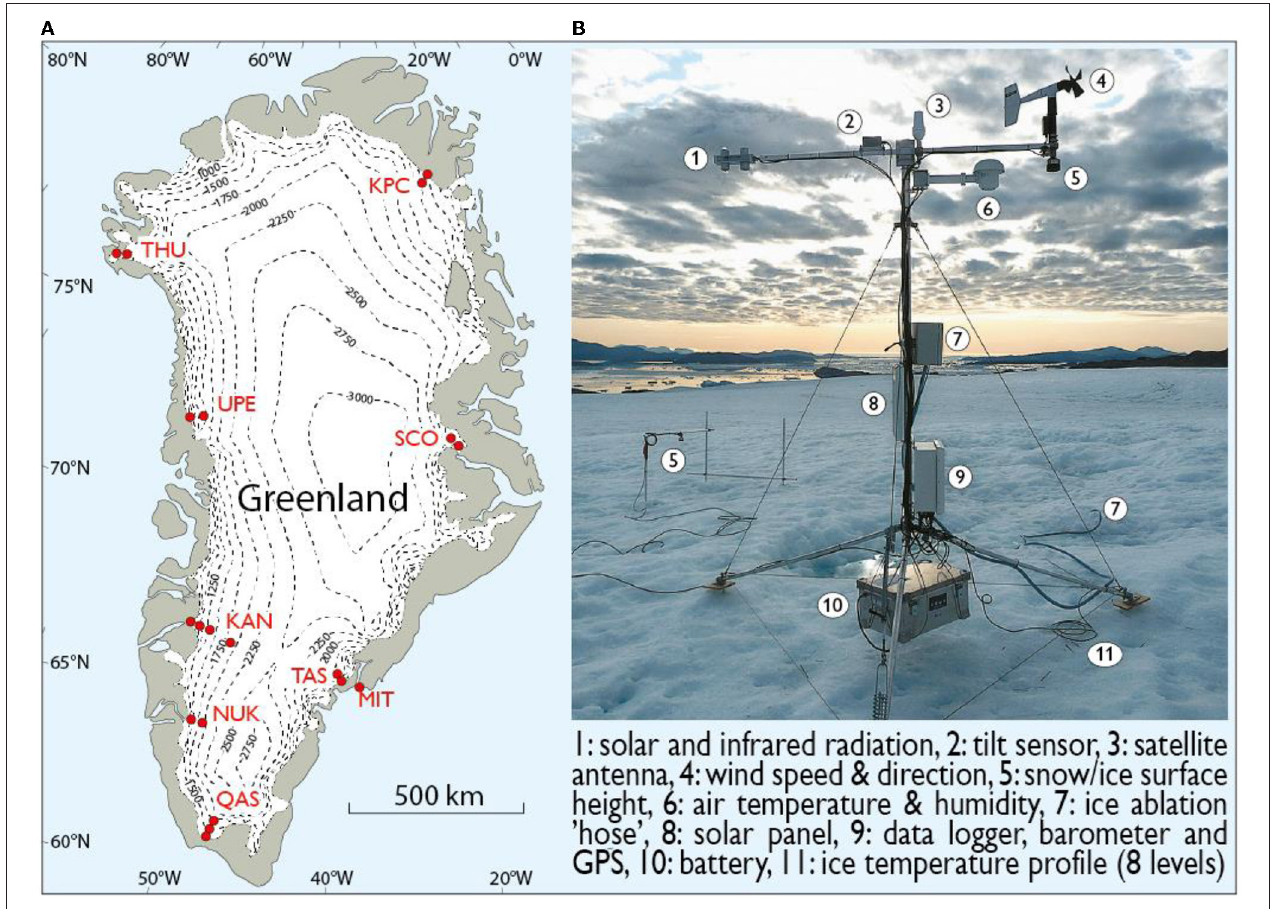
FIGURE 1 | (A) Map of Greenland with the locations of the PROMICE automatic weather stations. Dotted lines: elevation contours. (B) Photograph of a standard PROMICE